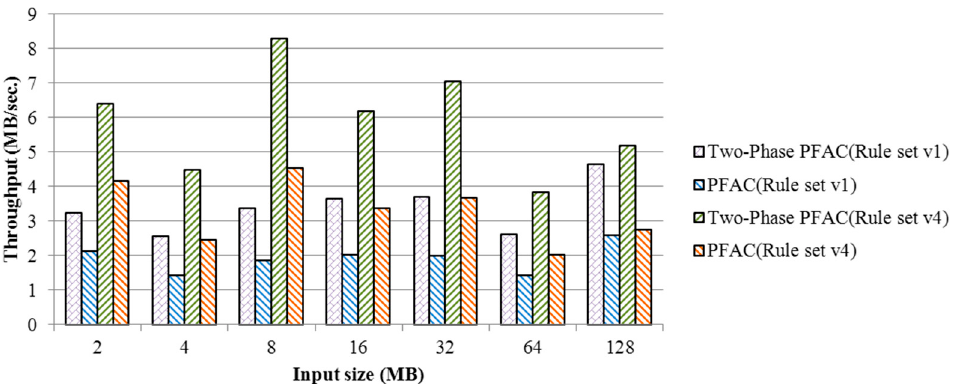
Figure 12. Comparison of throughput between two-phase PFAC and PFAC algorithms with different rule sets and input sizes on GTX TITAN X workstation.